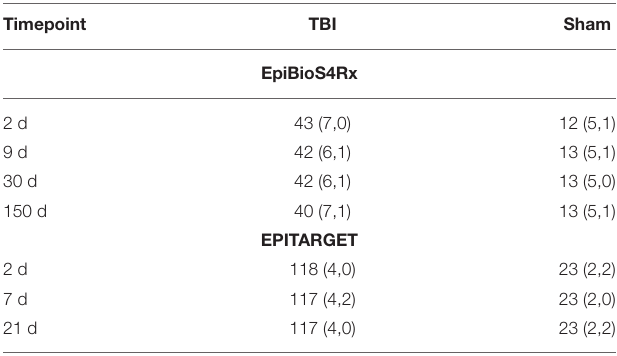
TABLE 1 | Number of MRI scans per cohort (EpiBioS4Rx, EPITARGET) in different time points and treatment groups [TBI, sham-operated experimental